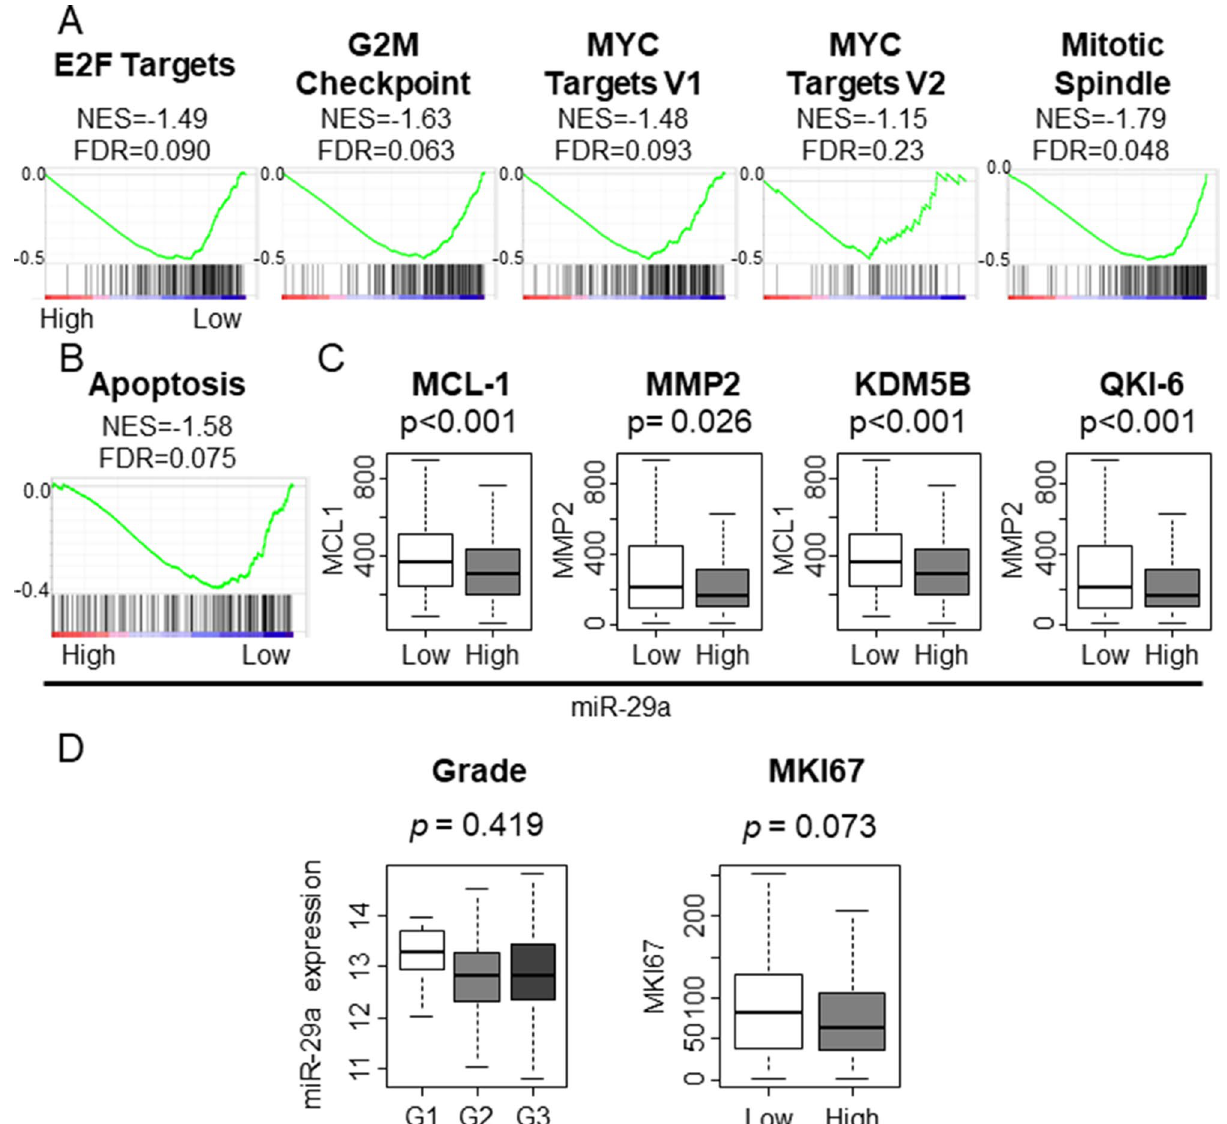
Figure 1. Association between miR-29a and pathological grade or MKI67 expression and gene set enrichment analysis (GSEA) in TCGA STAD cohort. ( A ) GSEA of cell proliferation-related gene sets. ( B ) GSEA of apoptosis-related gene sets. ( C ) The association between miR-29a and apoptosis-inducing genes. KDM5B lysine demethylation 5B, MCL-1 myeloid cell leukemia 1, MMP2 matrix metalloproteinase 2, QKI-6 Quaking gene isoform 6, NES normalized enrichment score, FDR false discovery rate. The statistical significance was defined by p < 0.05 or FDR < 0.25. Tukey-type boxplots demonstrate median and inter-quartile level values. ( D ) The association between miR-29a and pathological grade or MKI67 expression in TCGA cohort. Open box, shaded box, Closed box demonstrate Grade1, Grade 2, and Grade 3, respectively. The median cutoff of miR-29a was used to divide the group into two groups: high and low expression